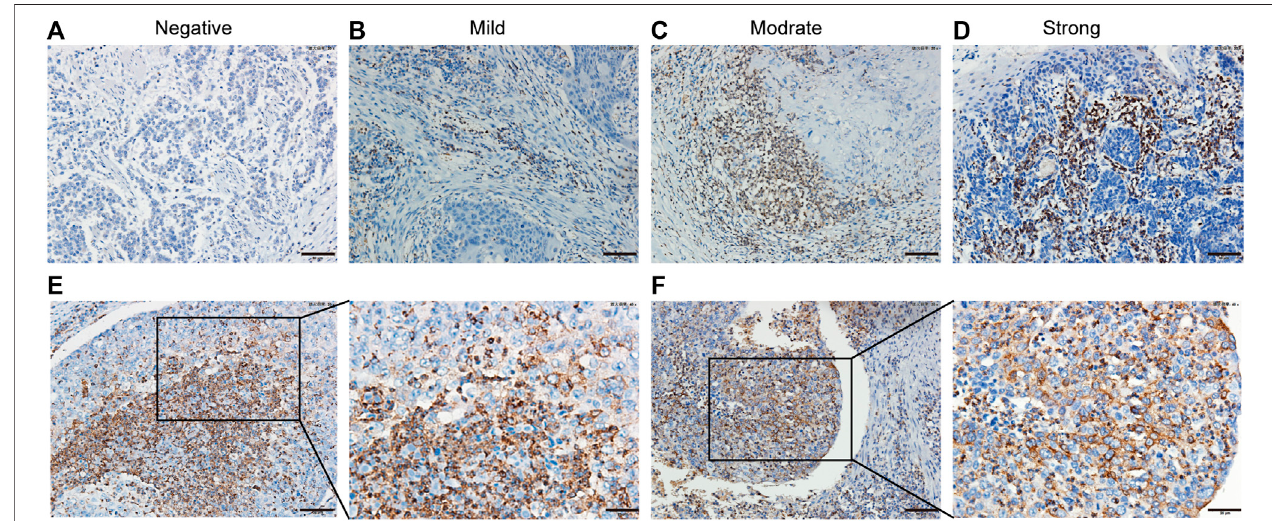
FIGURE 1 | PD-1H expression in ESCC analyzed by immunohistochemistry. (A – D) Immunohistochemistry staining of PD-1H in ESCC tumor tissues was performed and calculated using immunoreactive score (IRS), which was categorized as 0 – 1 (negative), > 1 – 4 (mild), > 4 – 8 (moderate), or > 8 – 12 (strong). Representative images of four categories of classi fi cation of PD-1H expression in ESCC tumor tissues are shown. (E – F) Two representative cases with strong positive PD-1H staining demonstrated that PD-1H protein was predominantly located in the membrane and cytoplasm of tumor cells and immune cells. Scale bars: 50 μ m,